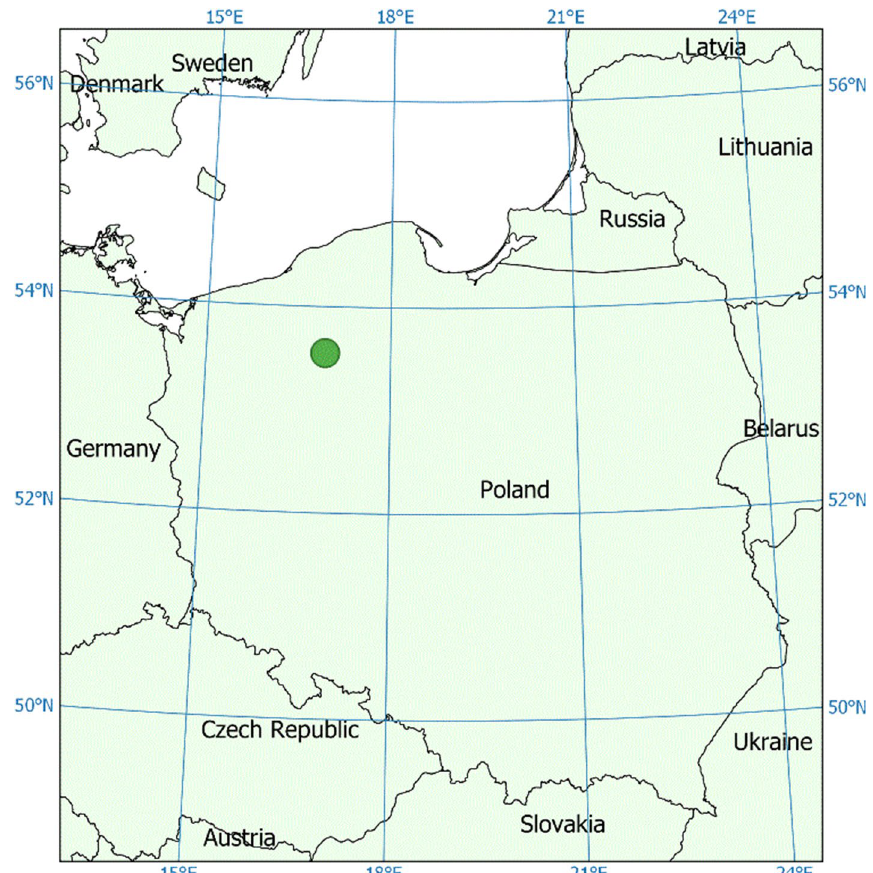
Fig. 1 The experimental design and location of sample plot. The letters ( A – C ) indicate different variants of mechanical site preparation, and the numbers (1–5) indicate different variants of the logging residue treatment